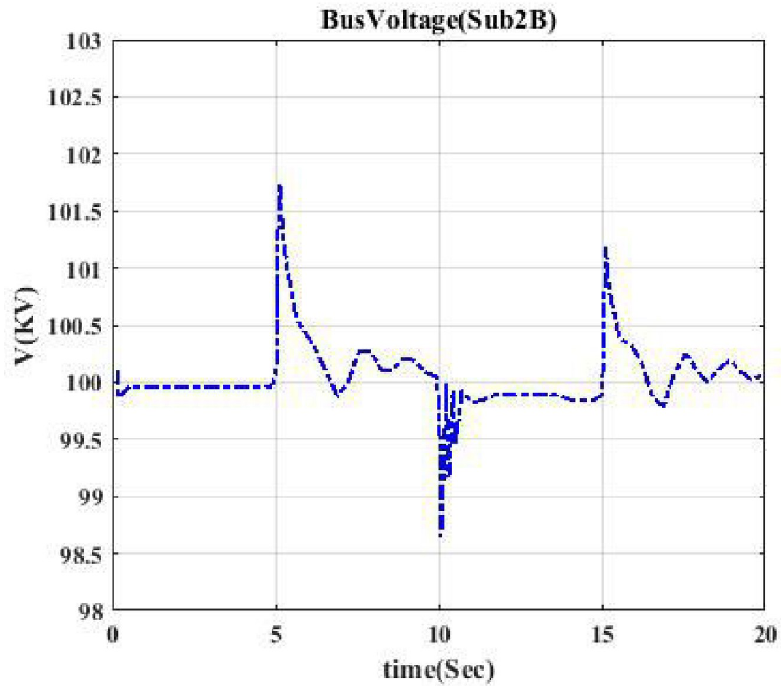
Fig 4. Voltage profile related to switching Sub2B-CB3. This shows the voltage curve when circuit breaker CB3 is switched.